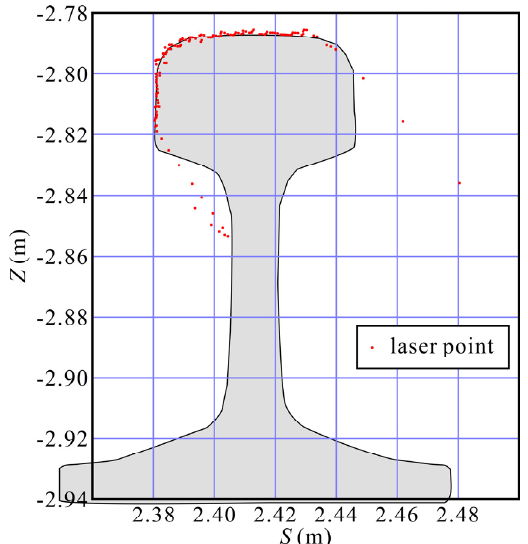
Figure 16. Laser points of the near rail of the scan line C